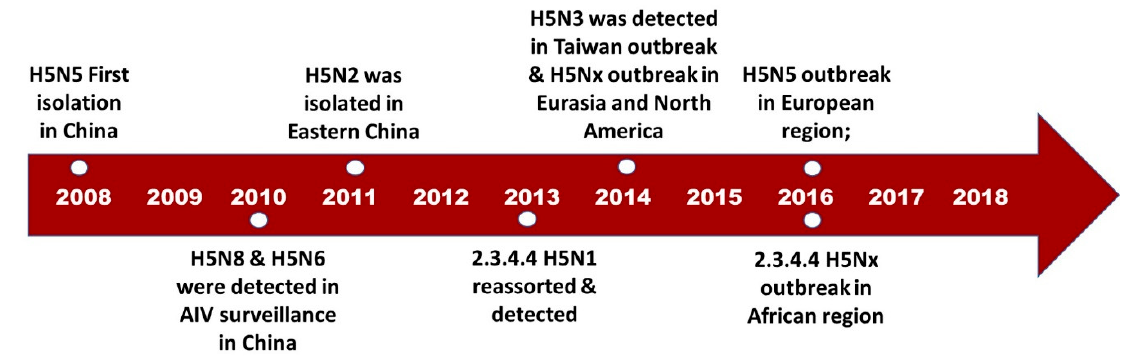
Figure 1. H5Nx timeline of evolution and continuous emergence (2008–2018).